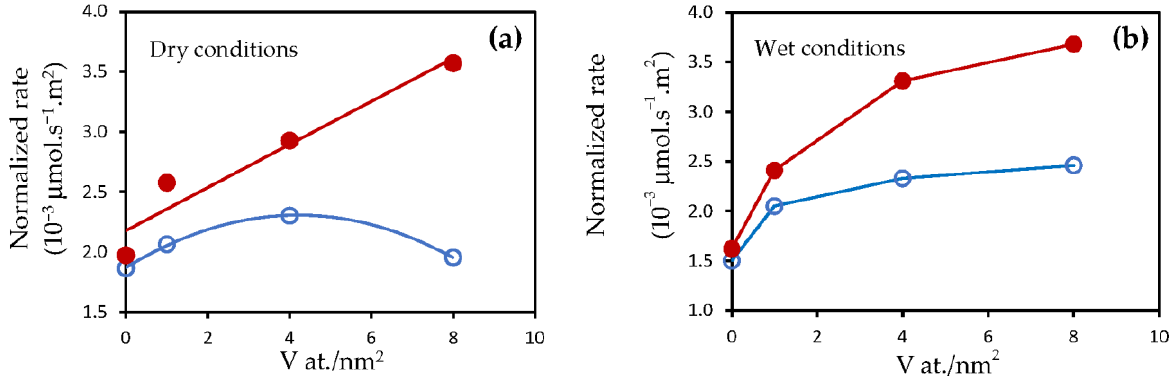
Figure 4. Vanadium density and relative concentration of vanadium dependencies of the normalized reaction rate of 2.1W- x V ( ) and 9.5W- x V ( • ) in ammonia-SCR: 400 ppm NO, 400 ppm NH 3 , 8 vol.% O 2 in the presence (wet conditions) or in the absence (dry conditions) of 10 vol.% H 2 O: ( a ) dry conditions; ( b ) wet conditions.